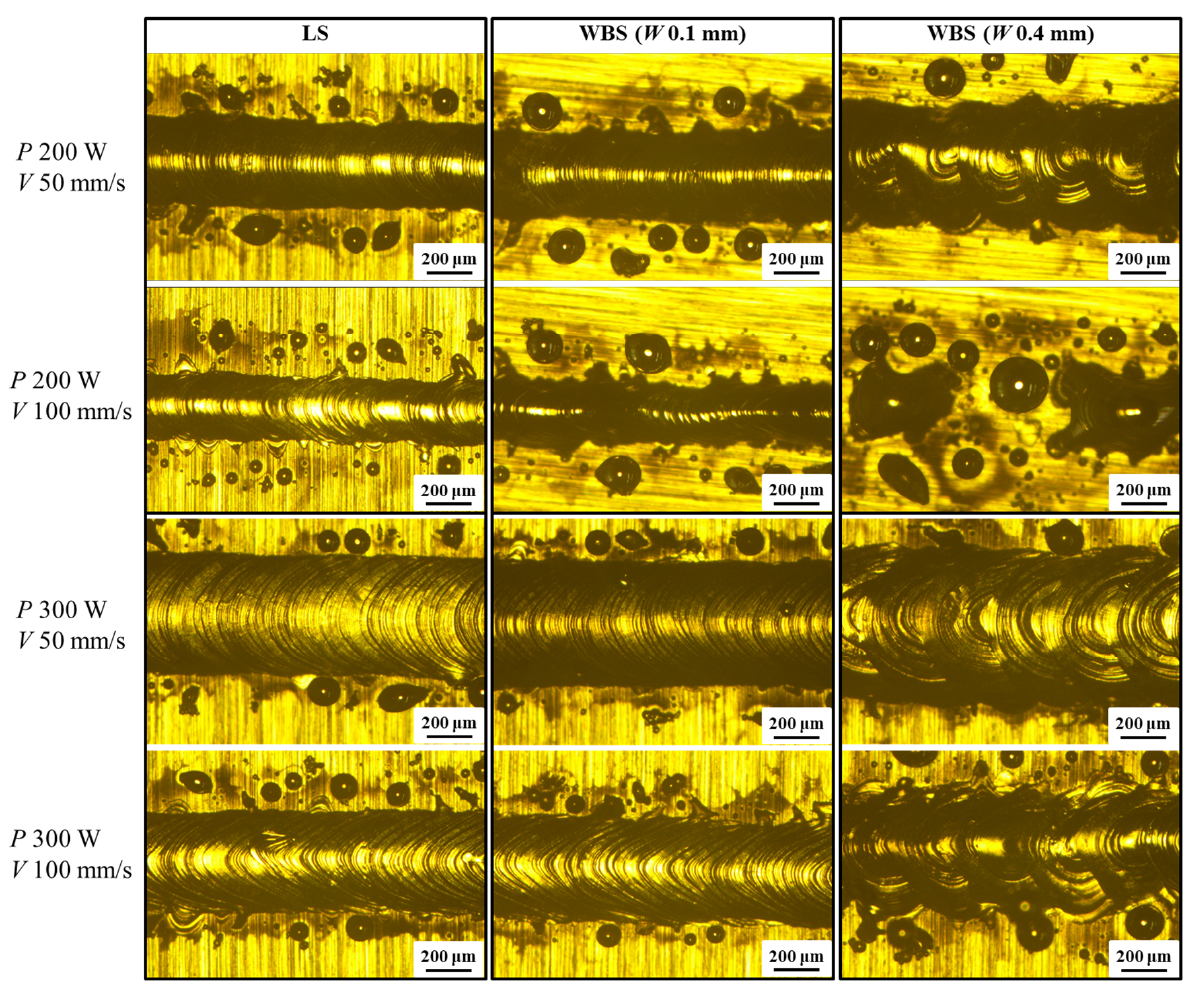
Figure 2. Line track melting morphology of LS and WBS under different parameters.